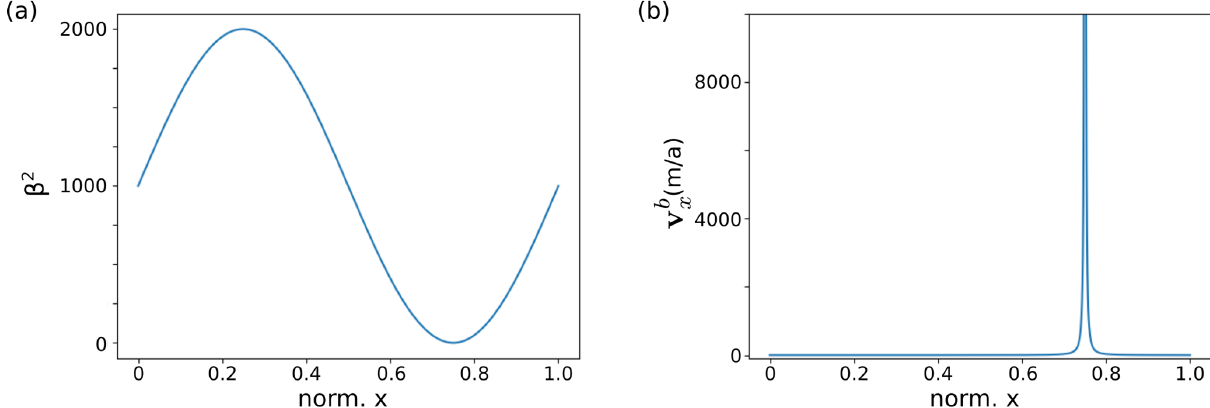
Figure 2. (a) Basal drag β 2 and (b) basal velocity v b x plotted according to Eqs. (9) and (10) and applying the SIA, plotted for L = 5000m. Notice the singularity in the velocity field, which develops because β 2 = 0 at x = 3 / 4 L , which is within the modeled domain.